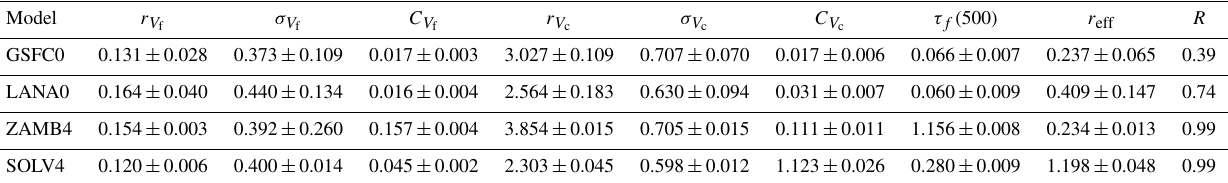
Figure 8. The effect of τ a errors on size distributions retrieved with the GRASP-AOD code for the cases of GSFC0 (low aerosol load conditions τ a ( 440 ) = 0 . 1) and SOLV4 (high aerosol load conditions τ a ( 440 ) = 1 . 5). As in Fig. 5, black solid lines are used to illustrate the reference values, while black dashed lines represent the retrievals without errors (self-consistency study). Red and blue lines are used to indicate the cases for which all the wavelengths present the errors of + (cid:15) i and − (cid:15) i respectively. Note that in the case of GSFC0, those two cases do not pass our residuals restrictions (i.e. we require total residual < 0 . 014 and relative residual < 15%). Shaded grey area illustrates all the retrievals for the multiple combinations of random errors. Table 8. Results obtained from the simulation of errors in τ a on GRASP-AOD code for the cases with the lowest and the highest aerosol loads. As in Table 7, the first six columns contain the parameters representing the bimodal log-normal size distribution (volume median radius ( r V , f r V [µm]), geometric standard deviation ( σ V and σ V ) and volume concentration ( C V , C V [µm 3 µm − 2 ])). The following columns contain c c c f f two secondary products derived from the GRASP-AOD inversion: fine-mode aerosol optical depth at 500nm ( τ f ( 500 ) ) and the effective radius ( r eff [µm]) (reference values in Table 3). The last column R indicates the fraction of the inversions that pass the filters out of the original 1000